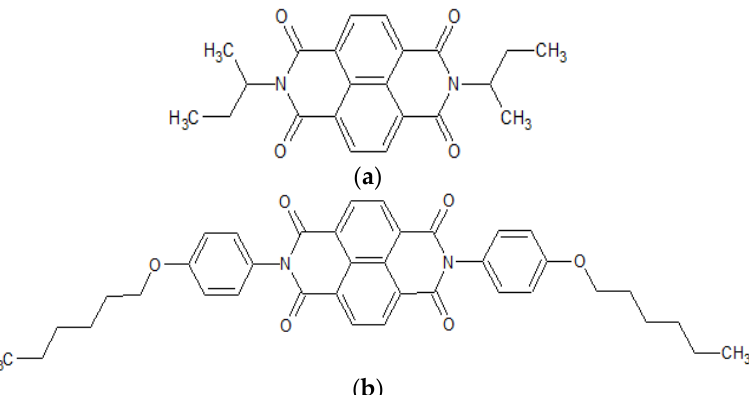
Figure 1. The structural formulae of N , N ′ -bis( sec -butyl)-1,4,5,8-naphthalenetetracarboxylic acid diimide (NDI-s-Bu) ( a ) and N , N ′ -bis(4-n-hexyloxyphenyl) − 1,4,5,8-naphthalenetetracarboxylic acid diimide (NDI-4-n-OHePh) ( b ).